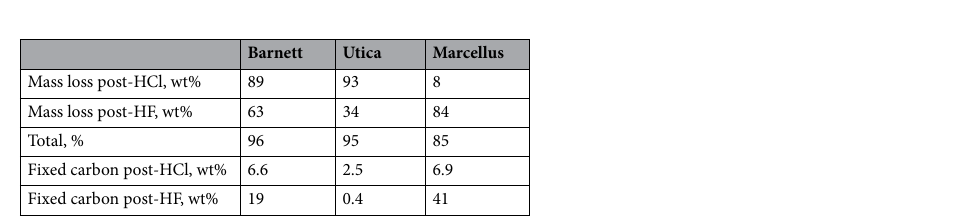
Table 4. Percentage mass loss and amount of fixed carbon after treatments with HCl and HF acids.